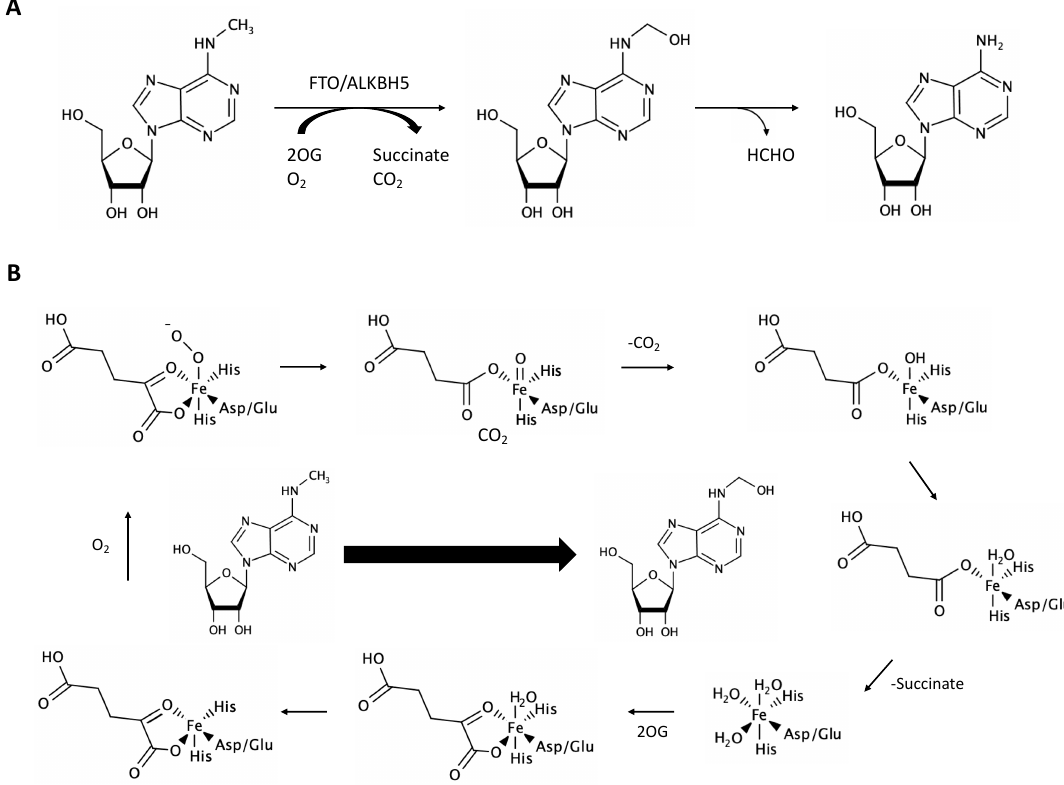
Figure 2. Molecular mechanism of N 6 -methyladenosine demethylation. ( A ) Overall biochemical process of m 6 A demethylation. ( B ) The enzymatic reaction of the first step of demethylation. FTO: fat mass and obesity-associated protein. ALKBH5: alkB homolog 5, RNA demethylase.